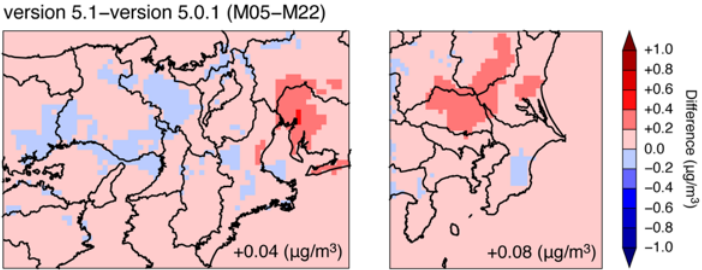
Figure 13. Spatial distributions of difference due to the model version from the comparison of M05 and M22 over (left) domain 3 and (right) domain 4 (see also Figure 6). The value shown in the lower-right side indicates the spatially averaged difference.